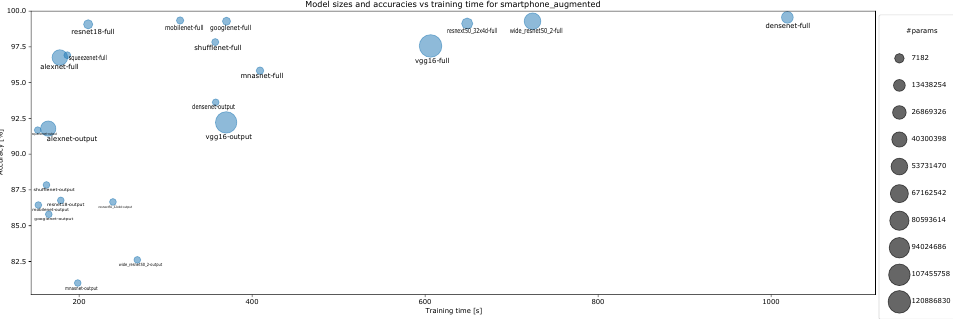
Figure A15. Accuracy vs. training time and model size for augmented smartphone data for ten- episode training.